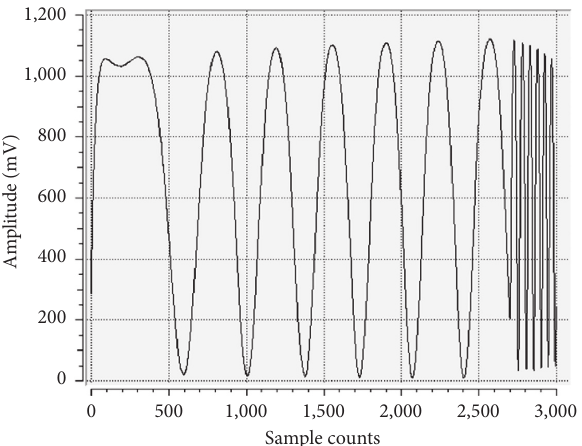
Figure 6: Filtered interfering cosine signal. Figure 7: Extreme values of interfering cosine